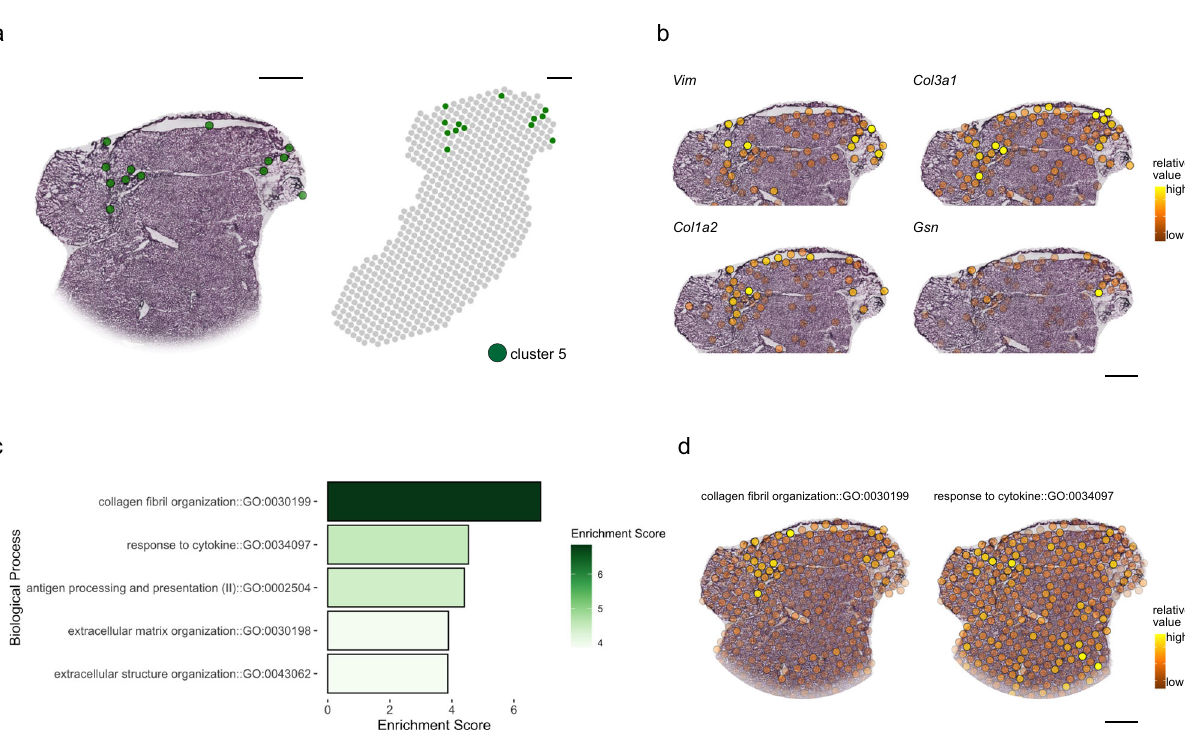
Fig. 4 Identi fi cation of liver tissue regions with unique transcriptional patterns. a Projection of spots including transcriptional patterns of cluster 5 in the UMAP and tissue (Fig. 1b), on the respective part of a histological section of the caudate lobe (left) and spot location in the entire tissue section (right). b Visualization of Vim , Col3a1 , Col1a2 and Gsn expression in spots of the same tissue section as in a . c Gene-ontology (GO:BP) enrichment for marker genes present in cluster 5. The Enrichment is given as the negative log10 algorithm of the adjusted p-value (g:SCS correction, Methods) of the differentially expressed marker genes in cluster 5. d Module scores of cluster 5 marker genes (Methods) associated with the two biological processes with the highest enrichment scores: “ collagen fi bril organization ” and “ response to cytokine ” are visualized on spots across the